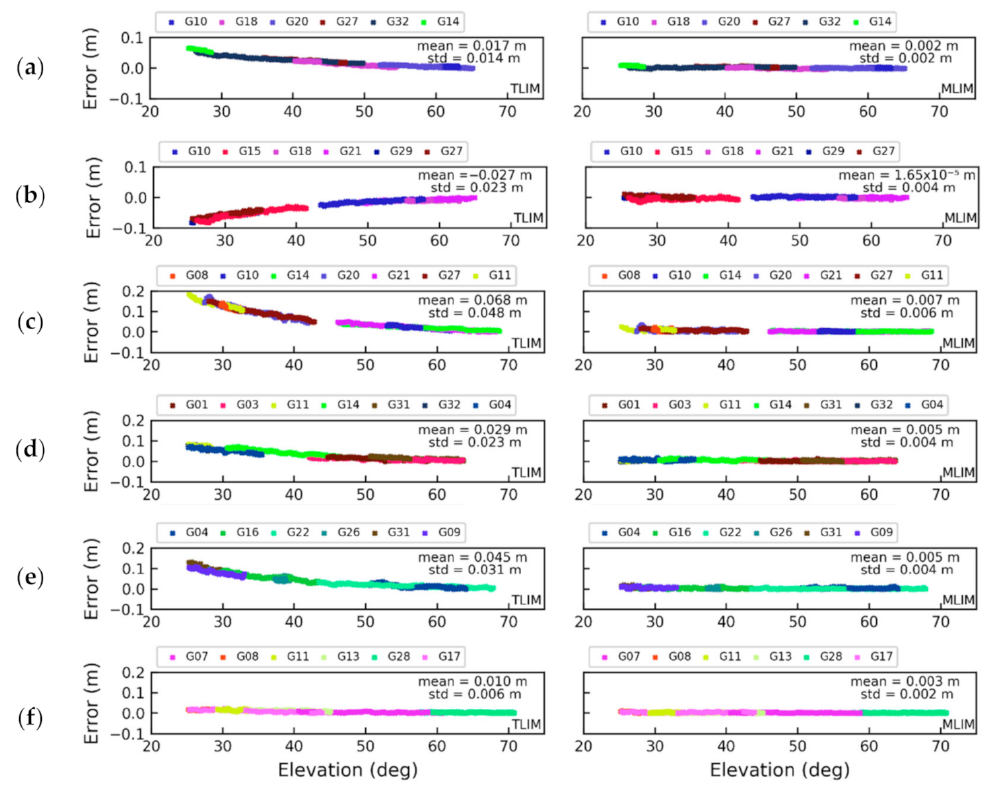
Figure 12. The DD tropospheric delay interpolation errors obtained by the TLIM and MLIM (left and right) with different satellite elevation angles at different rover stations: ( a ) P478, ( b ) EWPP, ( c ) P603, ( d ) P225, ( e ) WINT, and ( f ) P121.